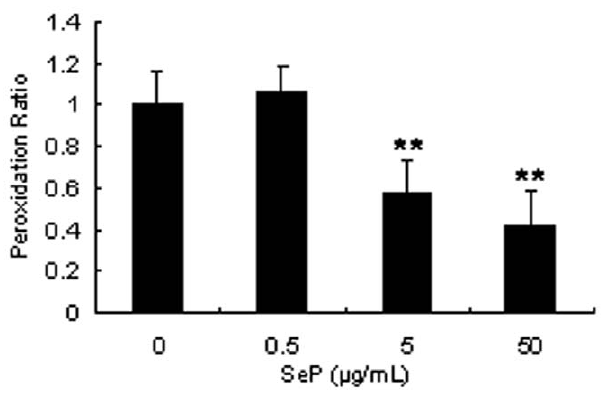
Figure 5. SeP suppresses lipid peroxidation in CEPI cells. The vertical axis shows peroxidation rate calculated from fluorescence intensity. Results are expressed as the mean 6 S.D. (n=4). Dunnett’s test was used to determine the significance of differences. ** and *** indicate a significant difference from the result of 0 m g/mL SeP addition, P , 0.01 and , 0.005, respectively. doi:10.1371/journal.pone.0009911.g005 concentration of albumin in tears is same as serum and makes up approximately 1% of the protein in tears [1]. In our previous study, 50 mg/mL albumin was applied as eyedrops for patients with severe dry eye caused by Sjogren’s syndrome [20]. The patients showed significant improvement in both their fluorescein and Rose Bengal scores, but the differences were not noted in tear break-up time or subjective symptoms.